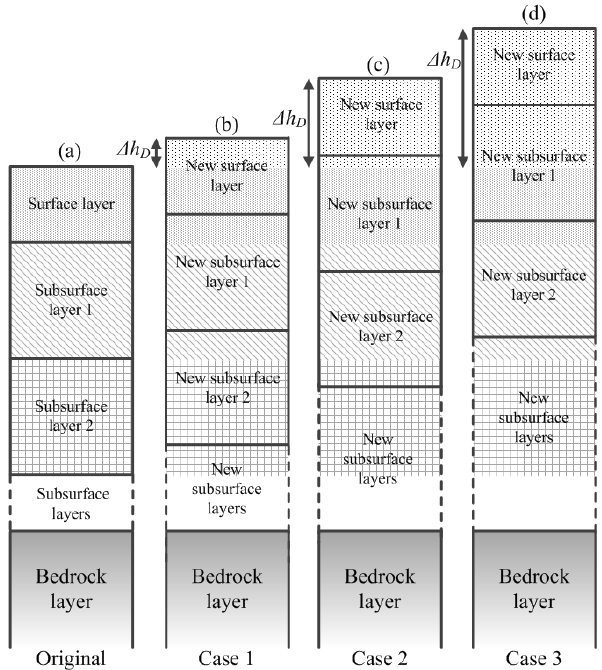
Figure 4. Different deposition